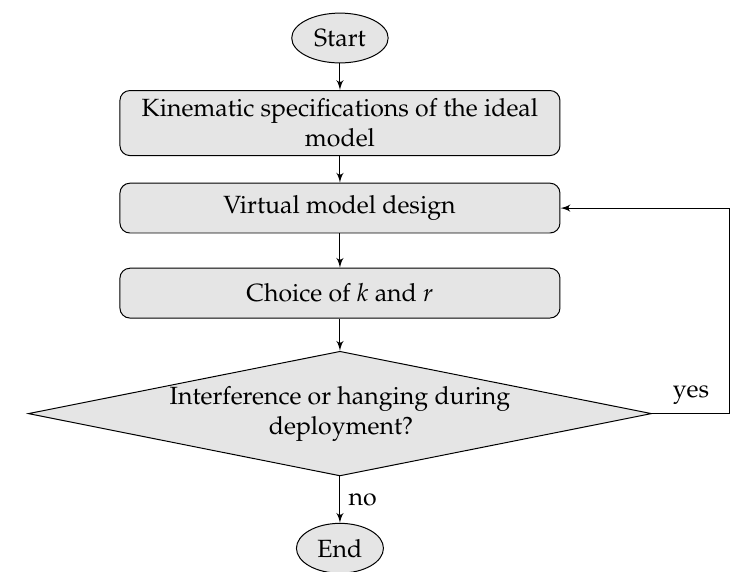
Figure 8. Phases of the mechanism design